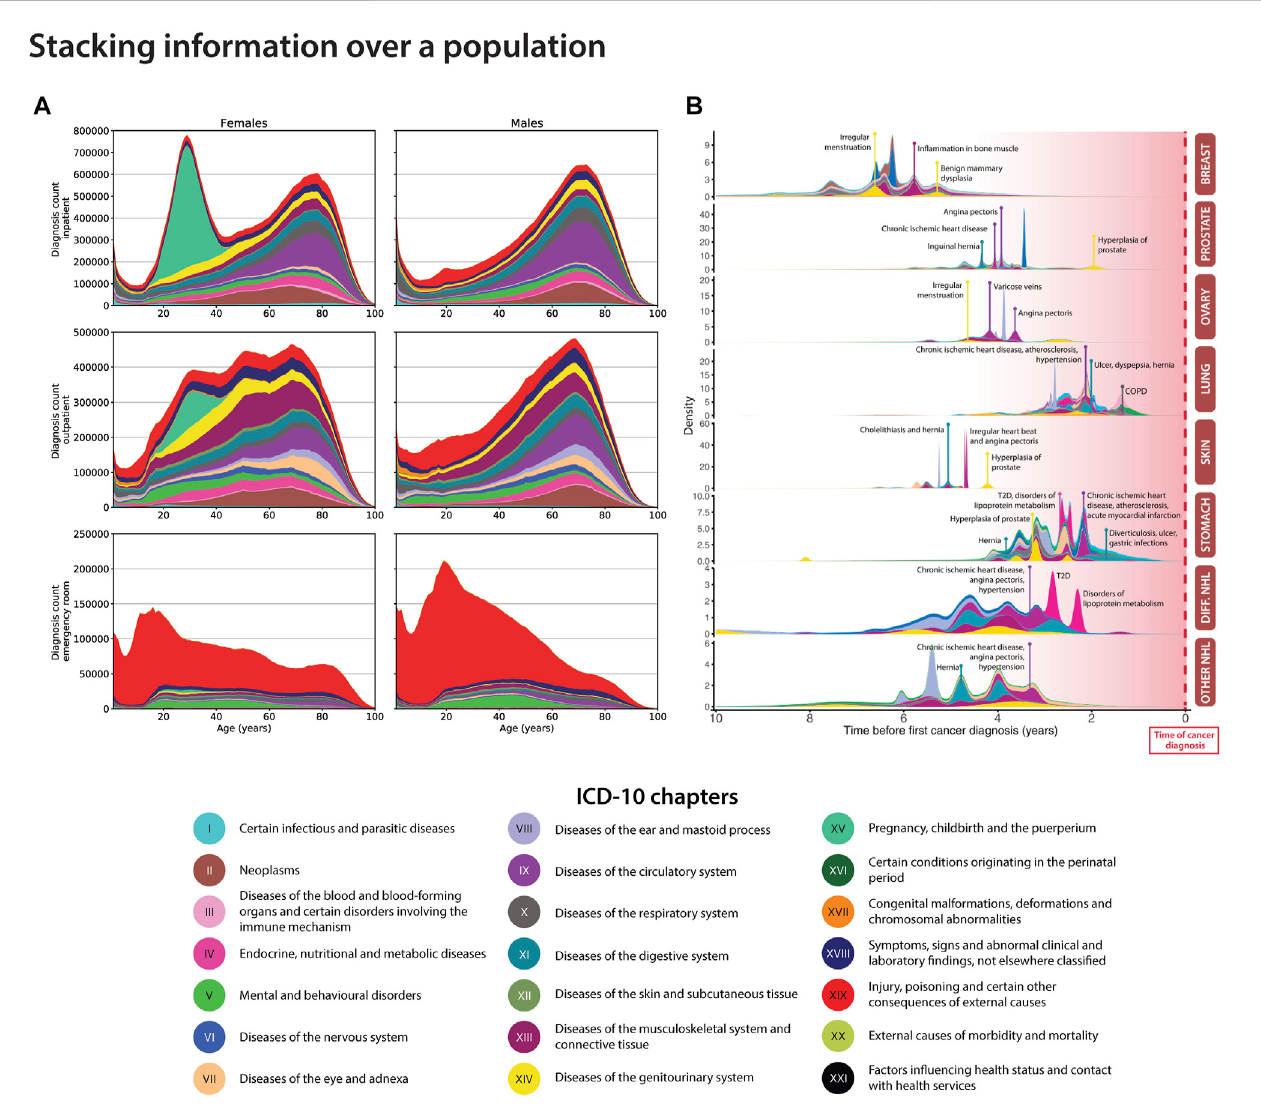
Densityplots for visualising healthdata for theDanish population. (A) . Thestacked density plotcompares theamountofICD-10chapters between sexes fortheentireDanishpopulation via theNationalPatientRegistry(NPR)(AdaptedfromJensenetal.(2014). (B). Thestackeddensityplotshowstheoccurrences of signi fi cant correlated disease pairs previous to top 8 cancer types (Hu et al., 2019). Breast: breast cancer; Prostate: prostate cancer; Ovary: ovarian cancer; Lung: lung cancer; Skin: skin cancer, Stomach: stomach cancer; Diff. NHL: diffuse non-Hodgkin ’ s lymphoma; Other non-Hodgkin ’ s